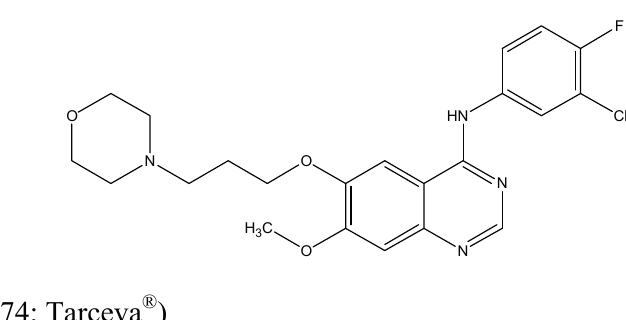
Figure 8. Structure of gefitinib.